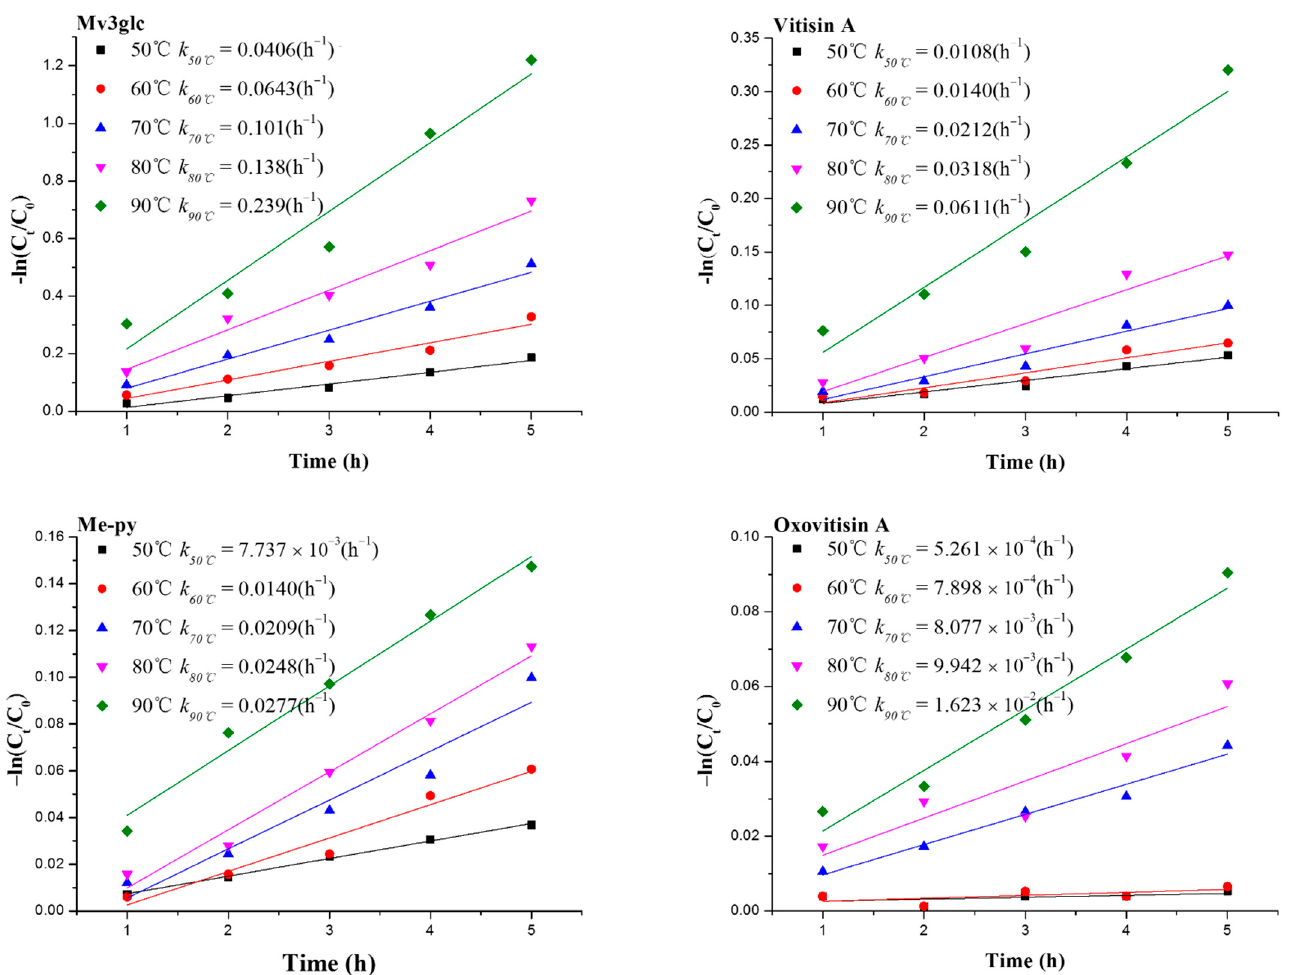
Figure 2. Degradation kinetic analysis of Mv3glc, vitisin A, Me-py, and oxovitisin A under different ◦ temperatures (50, 60, 70, 80, 90 °C). temperatures (50, 60, 70, 80, 90